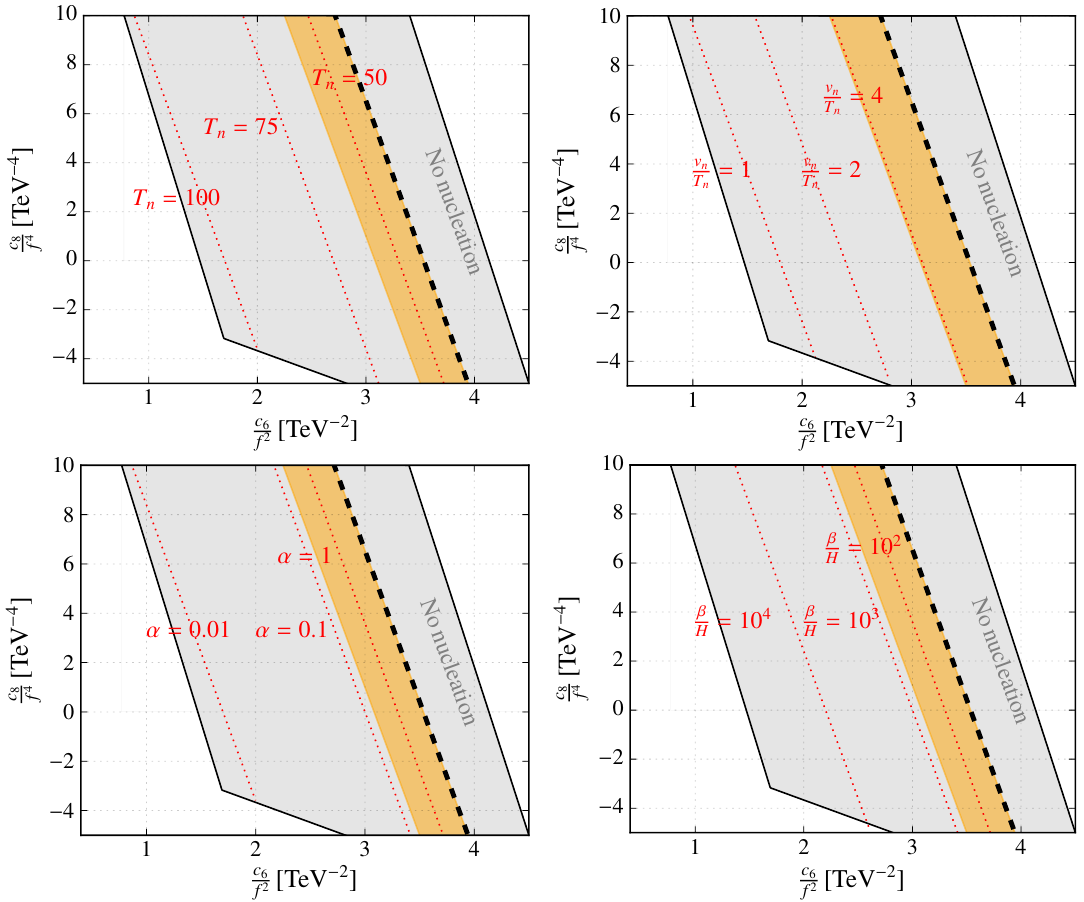
Figure 3 . Values of T n (top left), v T =T n (top right), (cid:11) (bottom left) and (cid:12)=H (bottom right) n characterising the SFOEWPT in the plane c 6 =f 2 { c 8 =f 4 . The labels of T n and T c are in GeV units. On the right of the grey area the condition in eq. (2.14) is violated. In the gray area to the right of the dashed line, the lifetime of the EW symmetric vacuum is longer that the age of the Universe, whereas on the left the transition results too weak for our purposes, i.e. v T =T n < 0 : 7. Below the n grey area, the EW vacuum at zero temperature is not the global minimum at scales below the cuto(cid:11) f = 1 TeV. In orange the parameter region LISA is sensitive to.